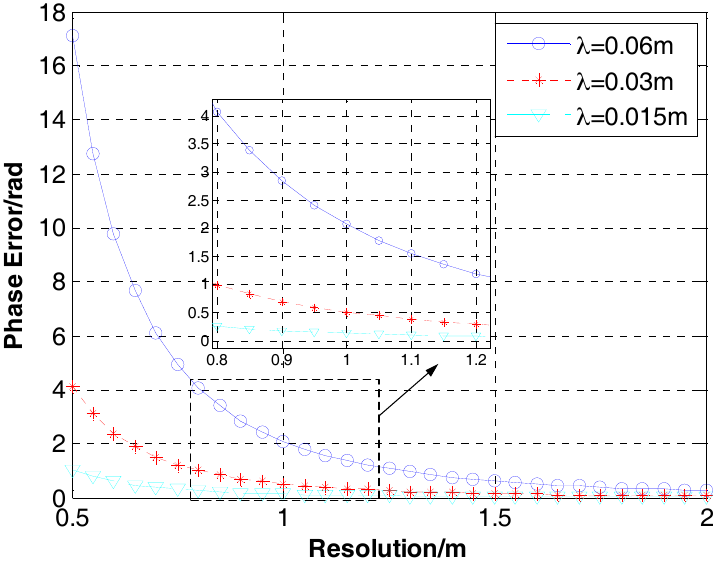
Figure 7. Phase error of targets in the edge (the distance departing from the referenced azimuth position is 2 km and the squint angle is 45°) varies with the azimuth resolution and wavelength. The blue solid line with ‘o’, the red dash line with ‘*’ and the cyan lineation line with ‘ ∇ ’ are the results with the wavelength equaling to 0.06 m, 0.03 m and 0.015 m, respectively.